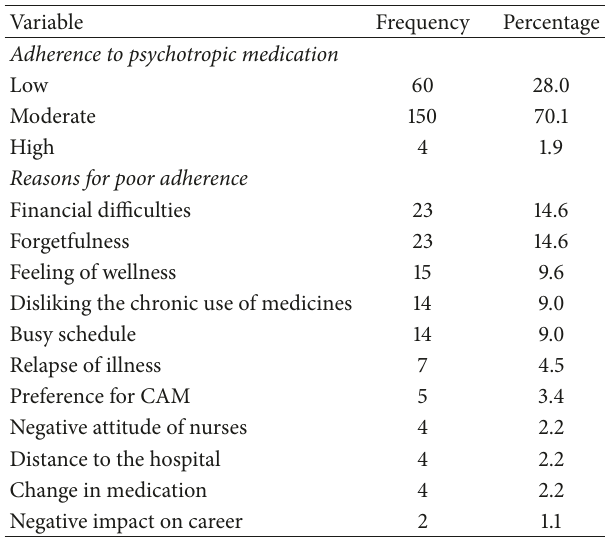
Table 8: Patient report of adherence to psychotropic